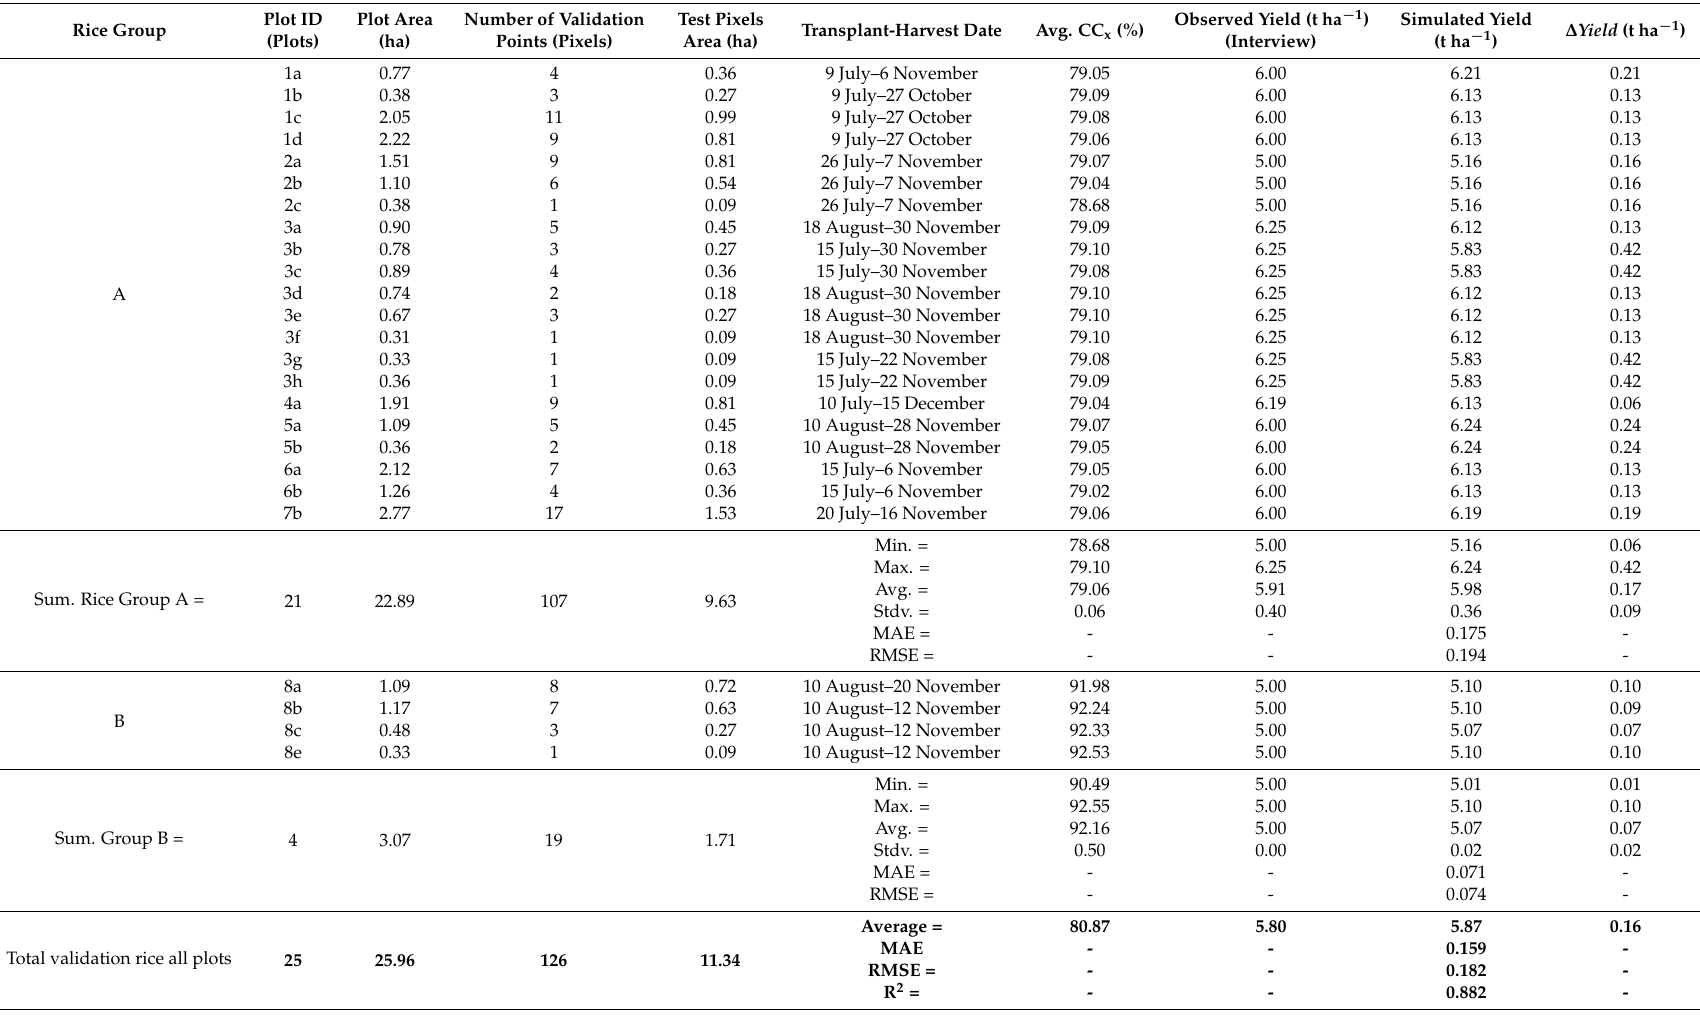
Table 8. Summary of testing points (126 pixels) used for validation of the AquaCrop model’s calibrated crop